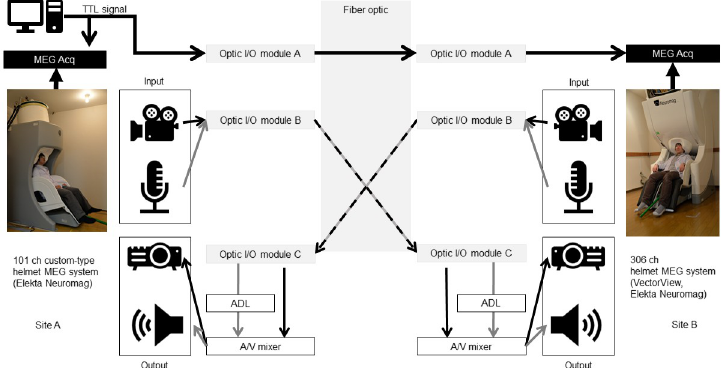
Fig 1. Connection overview. All signals were subjected to electrical/optic conversion, optical transmission, and optic/ electric conversion using Optic Input-Output modules (Optic I/O module A–C). The TTL signal was output from the PC at site A and recorded by the MEG data acquisition systems of each site. The timing standards were set using the TTL signal. The audio/video signal input/output unit serves as the communication device. The video signal is optically transmitted from the camera and presented from the projector via an A/V mixer. The audio signal is transmitted through the microphone, its latency matched to that of the video signal using an audio delay line, and then presented from the speaker via the A/V mixer. Photos: with permission by the